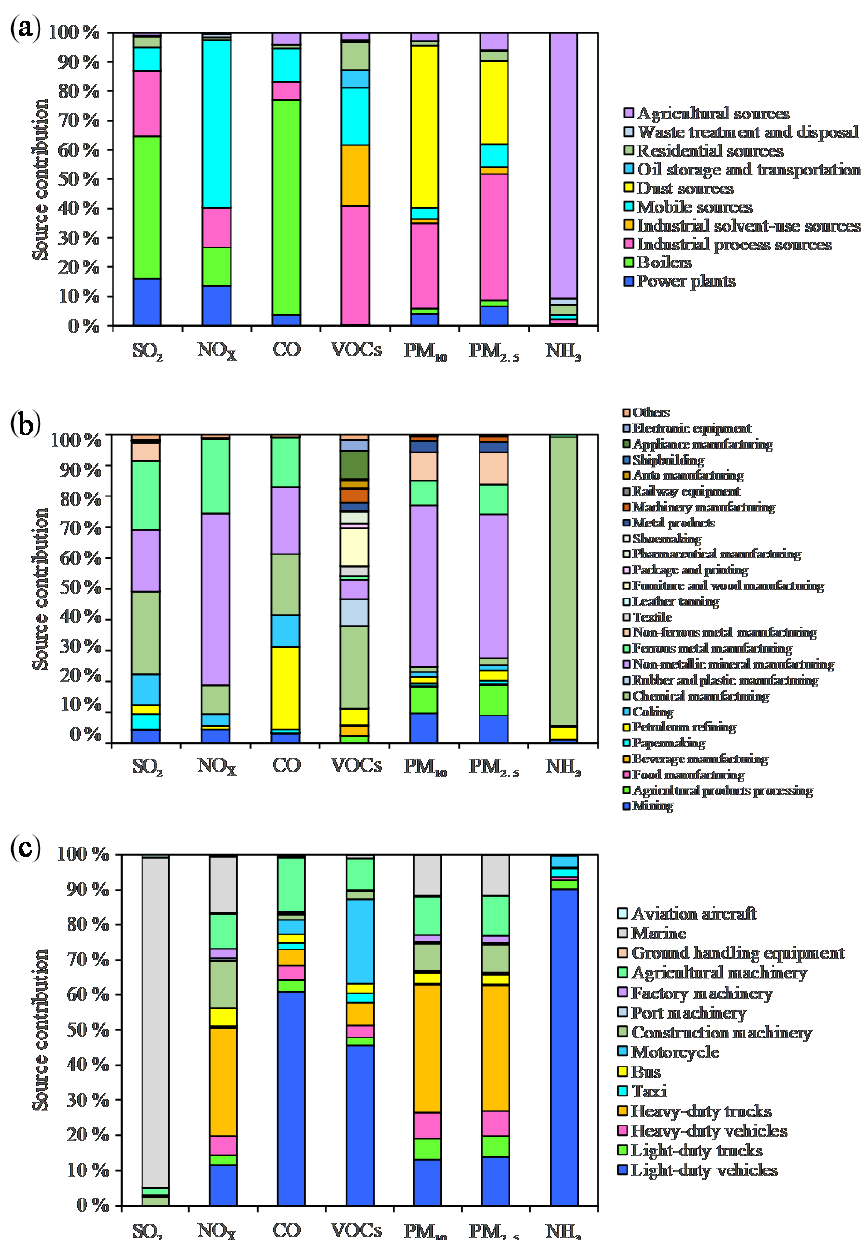
Figure 3. Emission contributions of major air pollutants in the YRD region from (a) major category sources, (b) industrial sector sources, and (c) mobile